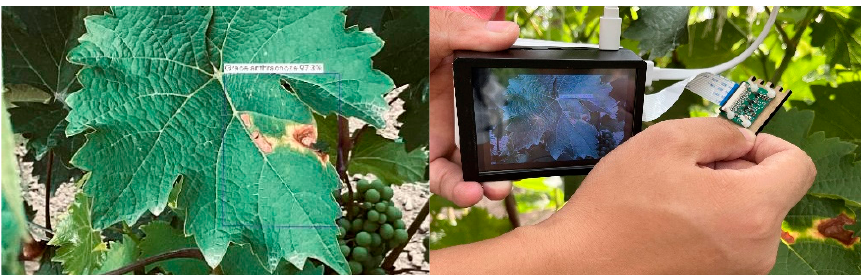
Figure 11. Verification of the Raspberry Pi field recognition function.